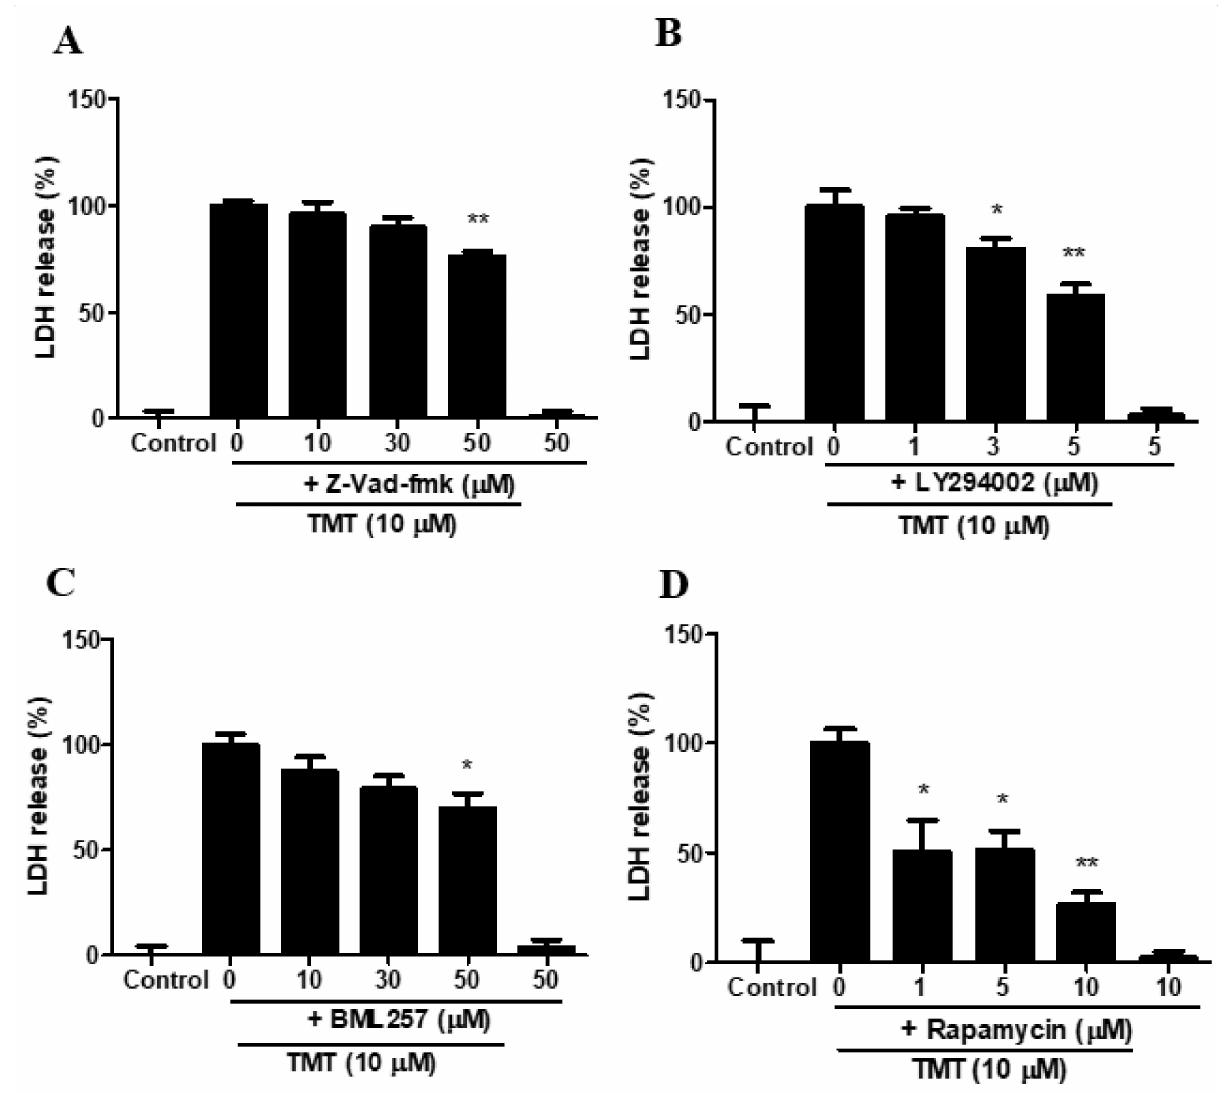
Figure 11. Protective effects of Z-Vad-fmk ( A ), LY294002 ( B ), BML257 ( C ), and rapamycin ( D ) against TMT-induced neurotoxicity in SH-SY5Y cells. Cytotoxicity was evaluated using a lactate dehydrogenase (LDH) release assay. * p < 0.05, ** p < 0.01 compared to 10 µ M TMT-treated group ( n = 4). Experiments were performed at least three times, with similar